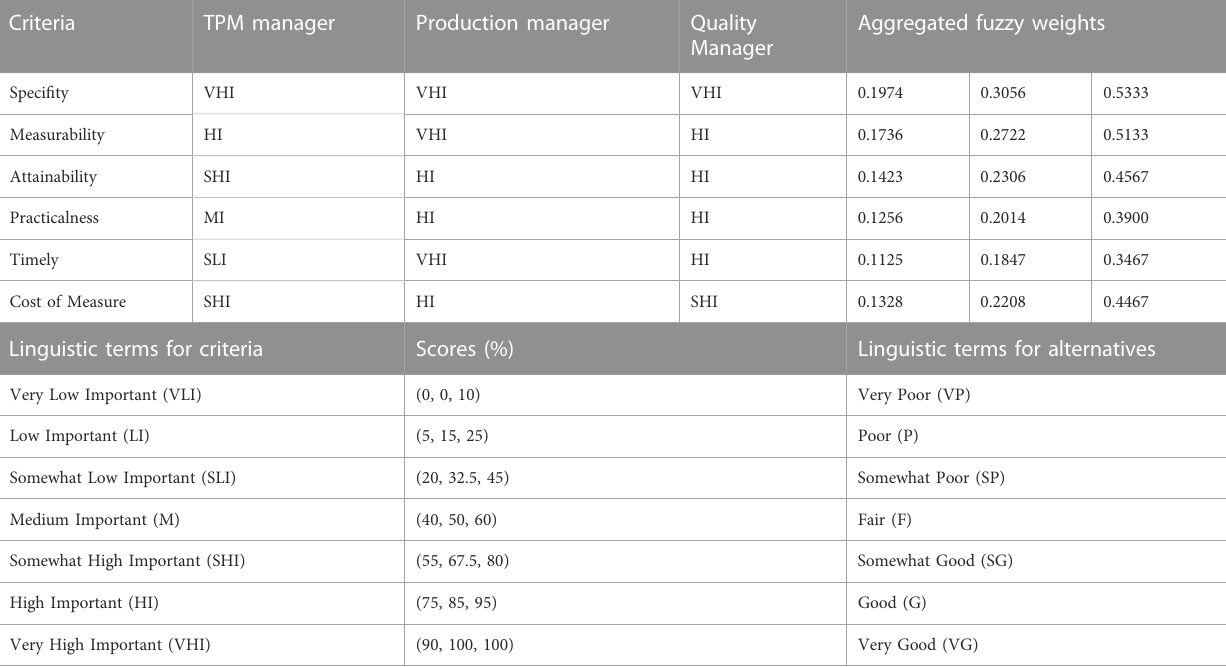
TABLE 4 Linguistic assessments for all of the criteria and their aggregated fuzzy weights.